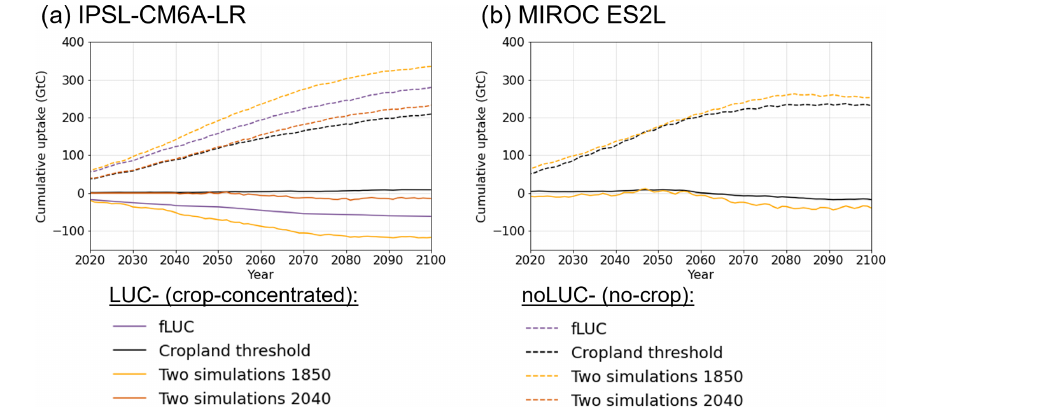
Figure 3. Cumulative land carbon uptake from the year 2000 in LUC-concentrated (solid lines) and noLUC (dashed lines) ecosystems estimated by three approaches by (a) IPSL-CM6A-LR and (b) MIROC-ES2L.